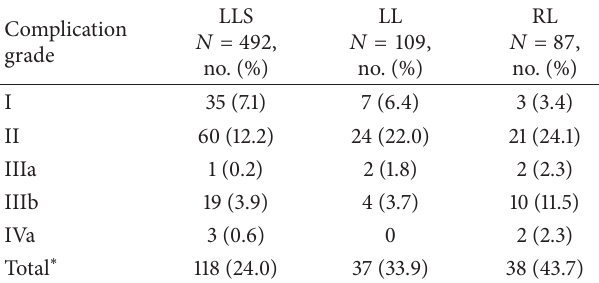
Table 4: Classification of complications according to Clavien- Dindo among the types of liver resection.